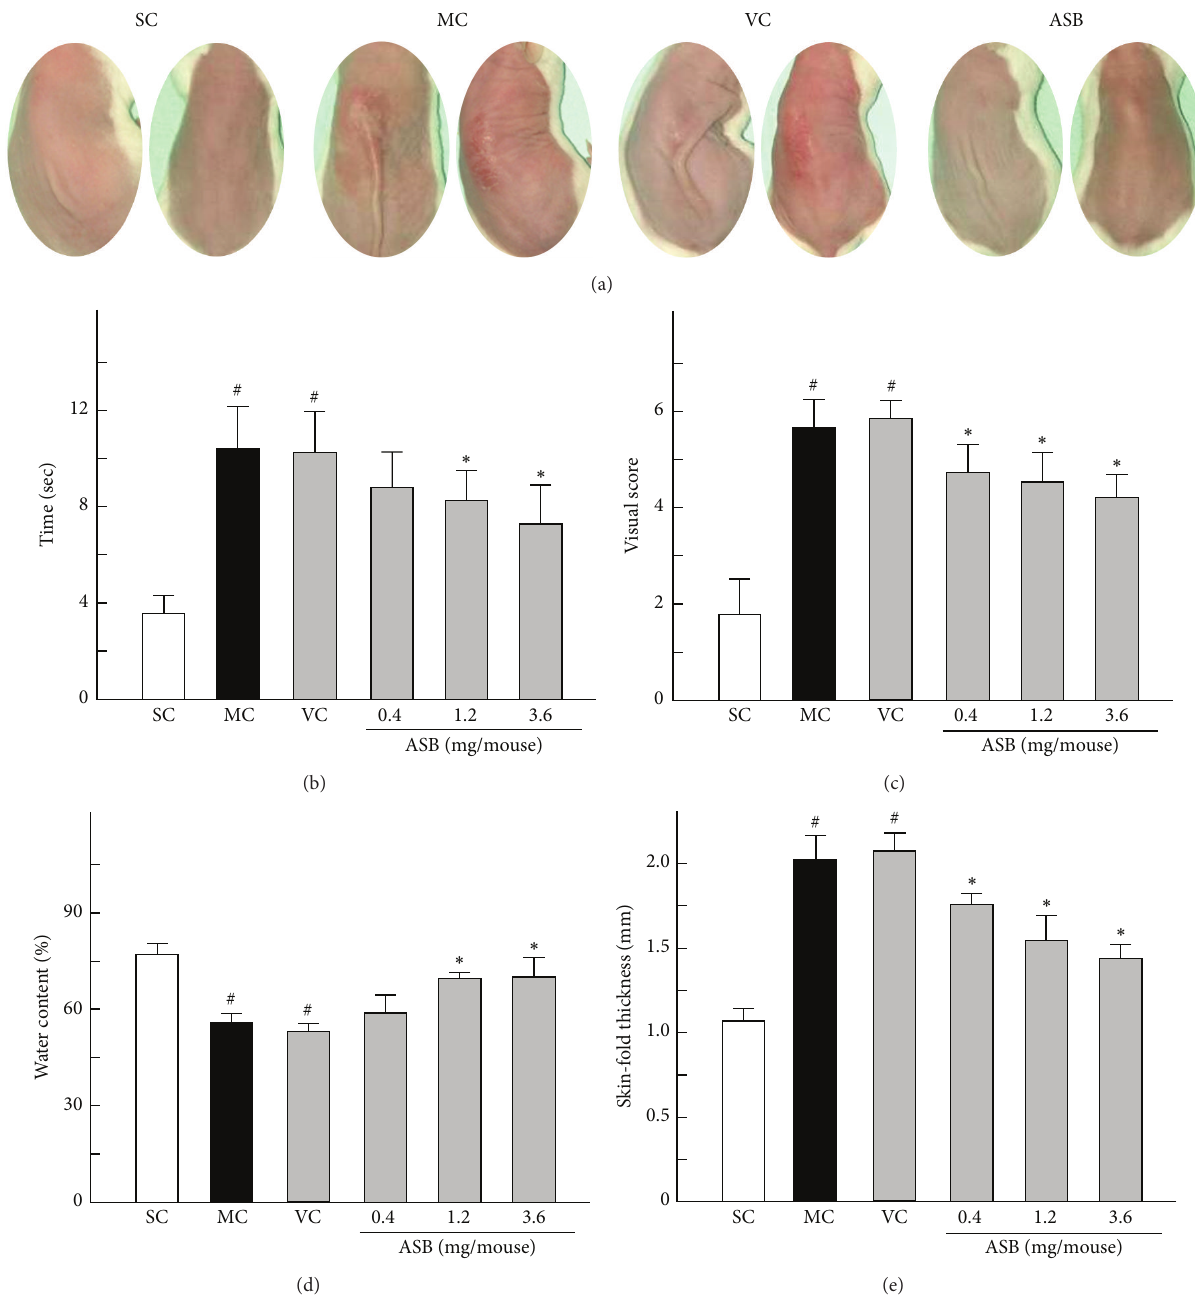
Figure 2: Evaluation of skin clinical observation at the end of experiment period. (a) (left) Pinch test was performed according to the method described by Tsukahara. (a) (right) Macroscopic changes of mice with different treatments were performed. (b) Recovery time in the pinch test of different groups was evaluated. (c) The trend of macroscopic changes reflected in the changes of visual scores was expressed according to the method described by Bissett et al. (d) Water contents of mice skin with different treatments were measured. (e) Skin-fold thickness of dorsal skin of different experiment groups was measured using a caliper. Data represents means ± SD ( 𝑛 = 8 ). # 𝑝 < 0.05 compared with the SC group; ∗ 𝑝 < 0.05 compared with the VC group. NC, normal control; SC, sham control; MC, model control; VC, vehicle